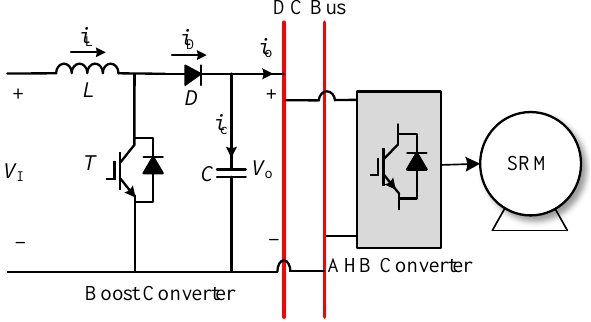
Figure 12. Setup of the experimental system.